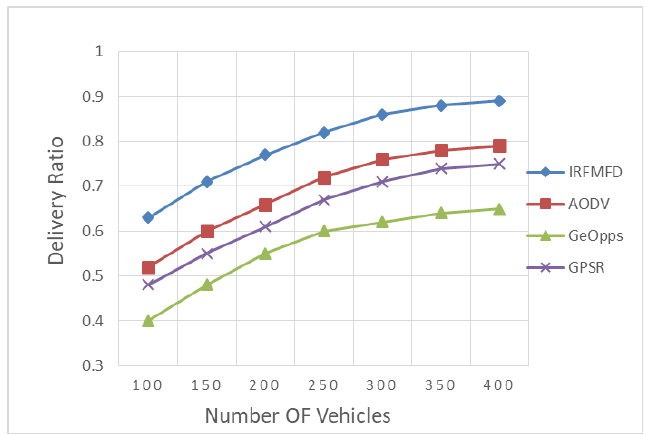
Figure 7. Packet delivery ratio with different numbers of vehicles . Appl. Sci. 2020 , 10 , x FOR PEER REVIEW